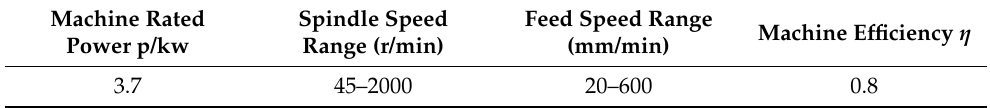
Table 4. Drilling Machine Parameters.